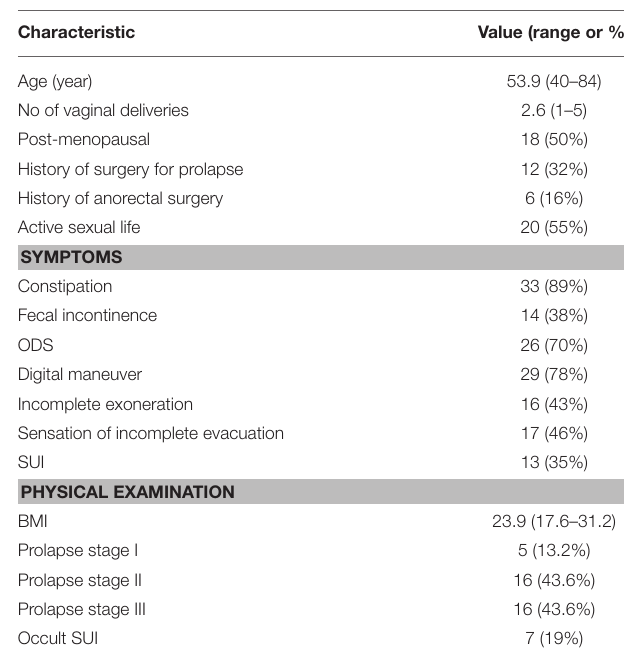
TABLE 1 | Patients